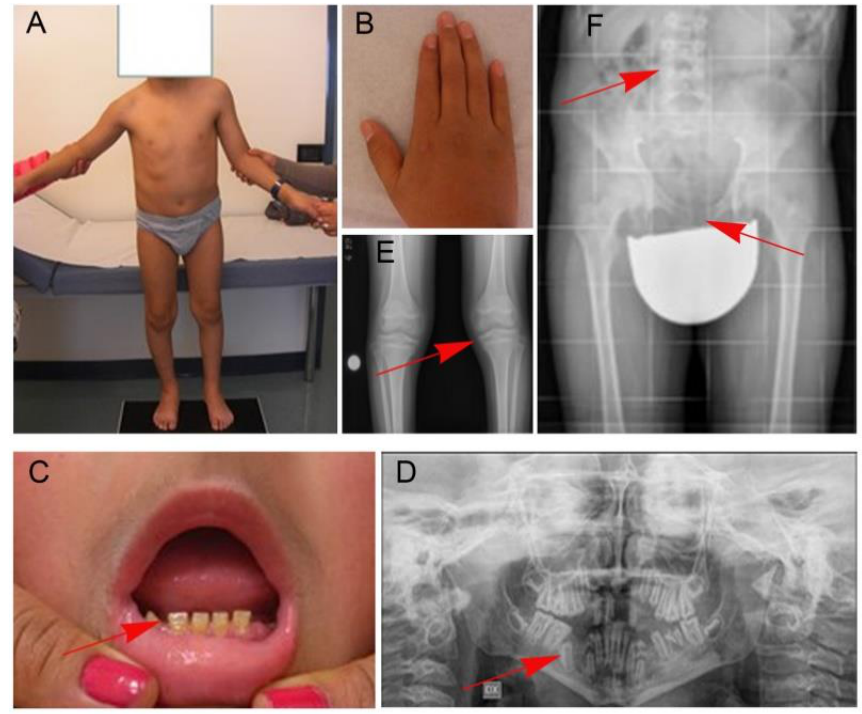
Figure 1. Clinical features of the subject with the homozygous LTBP3 splice site variant. Proband’s photographs showing short trunk, varus knees, upper limbs diplegia ( A ) and brachydactyly ( B ). The subject also showed amelogenesis imperfecta and hypodontia ( C ). Radiographic examinations of the dental archs, lower limbs, pelvis and trunk demonstrated oligodontia (red arrow in panel ( D ), slightly widened appearance of the proximal epiphyseal region of the tibiae and of the distal epiphyseal region of the femurs ( E ), platyspondyly ( F ). The boy had difficulties in standing and walking. Brain magnetic resonance imaging (MRI) showed no relevant anomalies. He had normal intelligence. Karyotype and array- CGH analyses were normal.